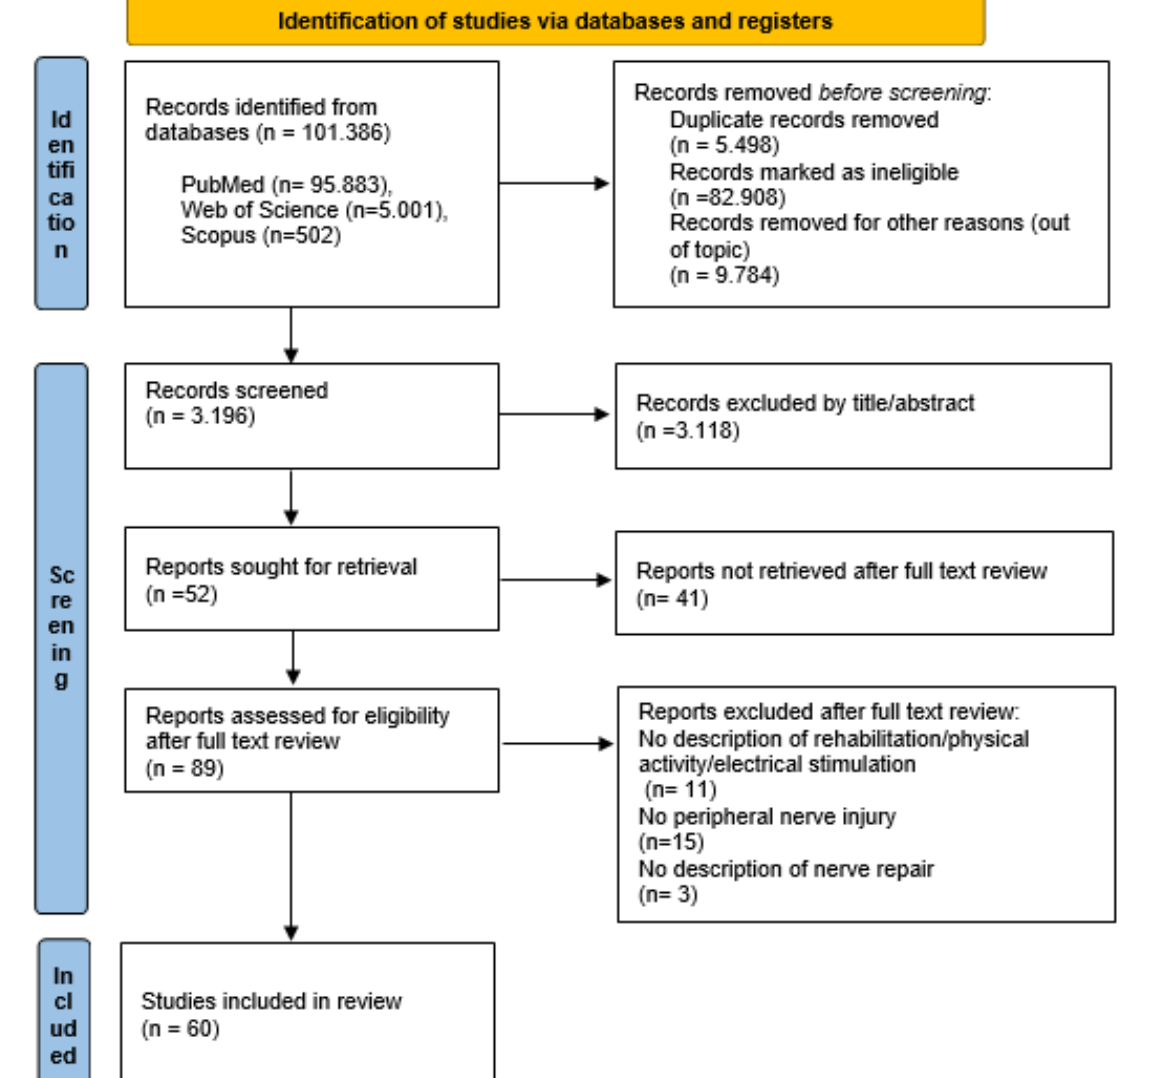
Figure 1. Flow chart of the process of initial literature search and extraction of studies meeting the inclusion criteria.